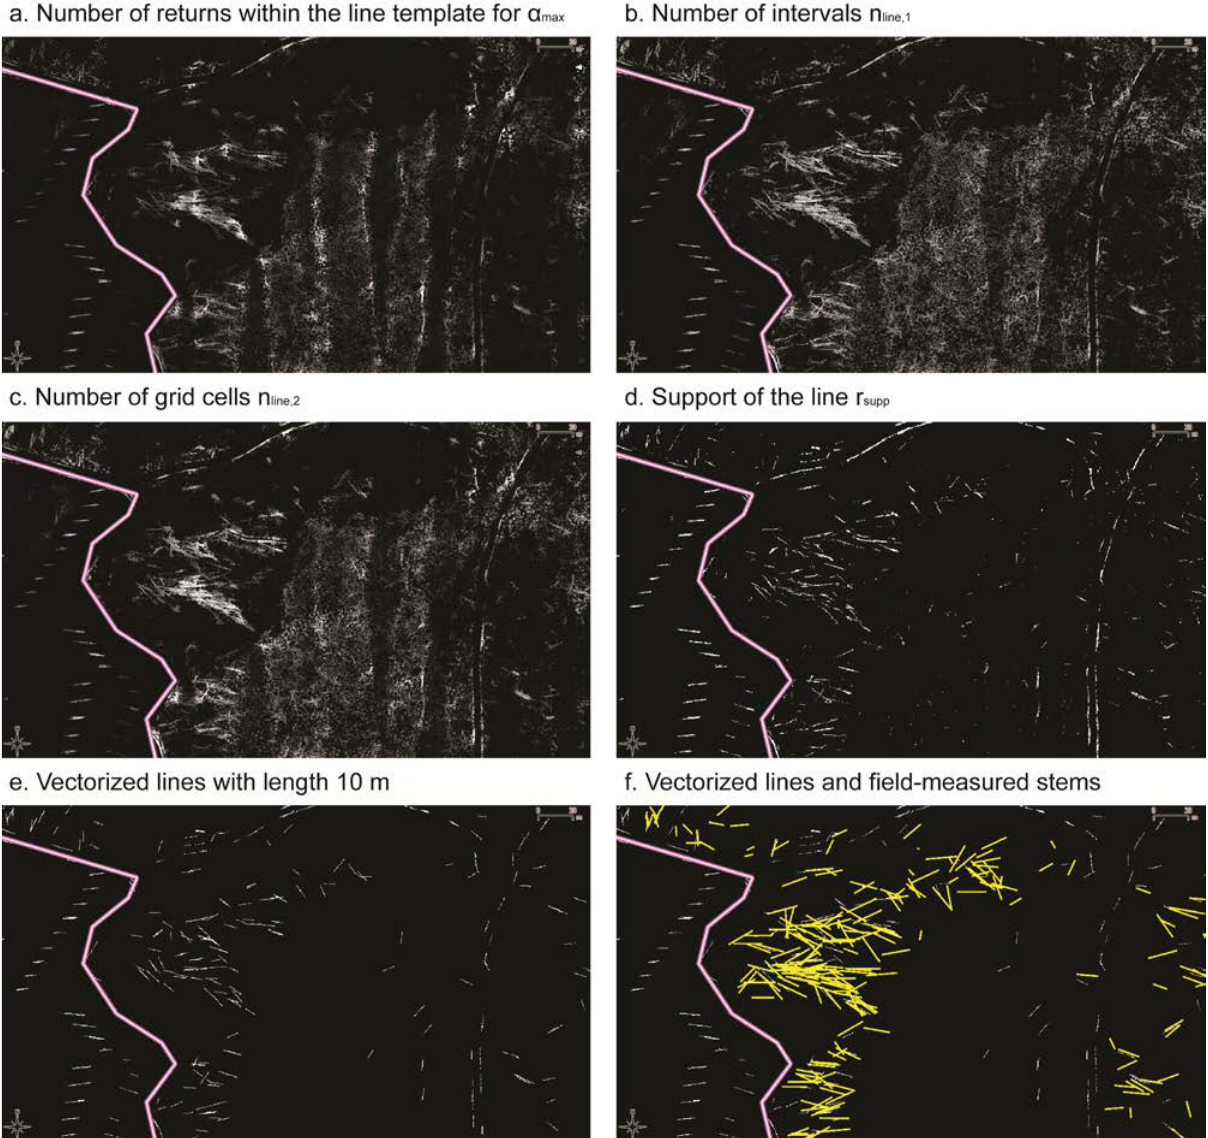
Figure 4. Example of rasters inside the white box in Figure